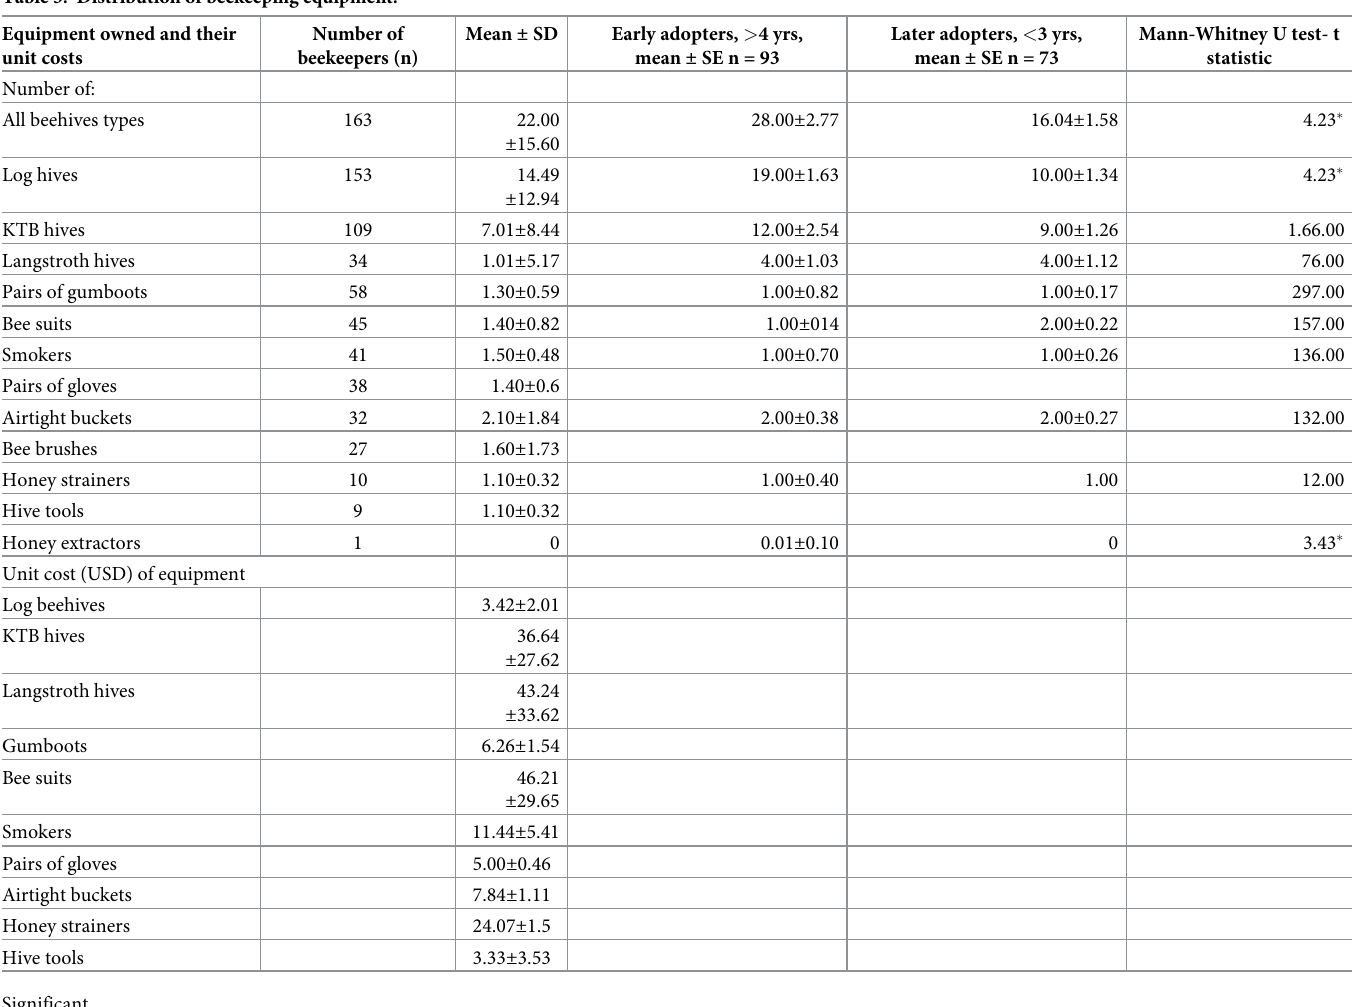
Table 3. Distribution of beekeeping